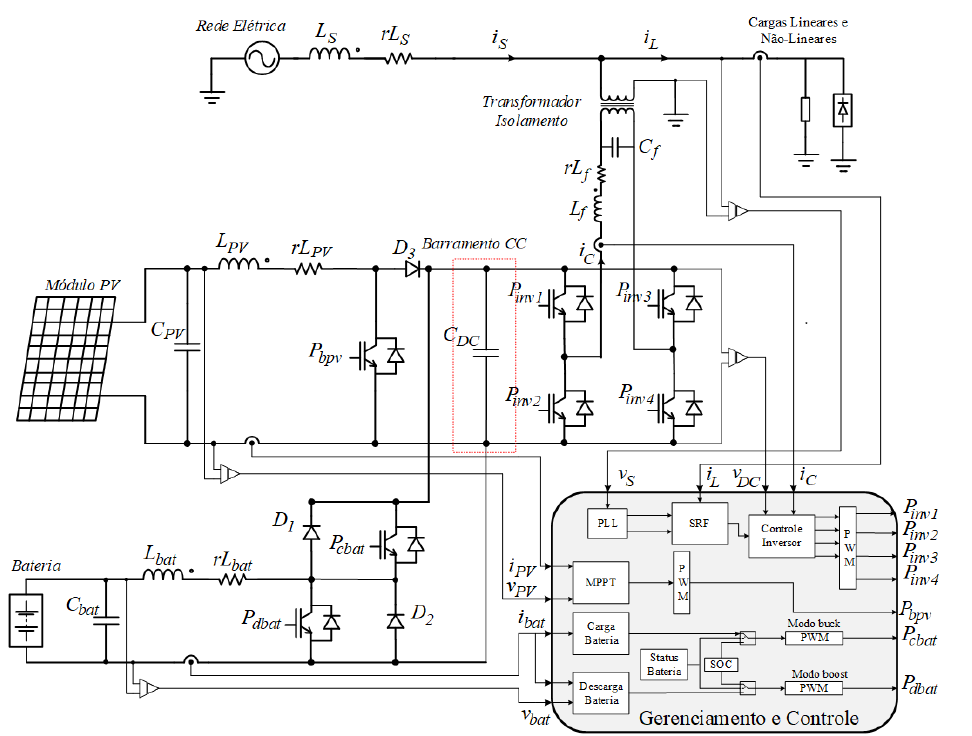
Figure 2. Proposed nanogrid structure with active energy